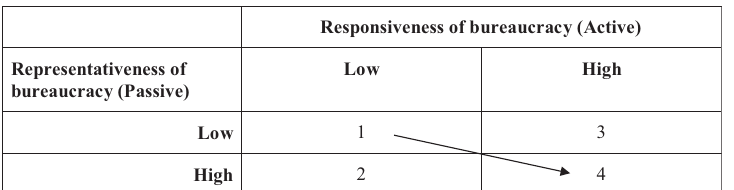
Figure 1. Representative and responsive